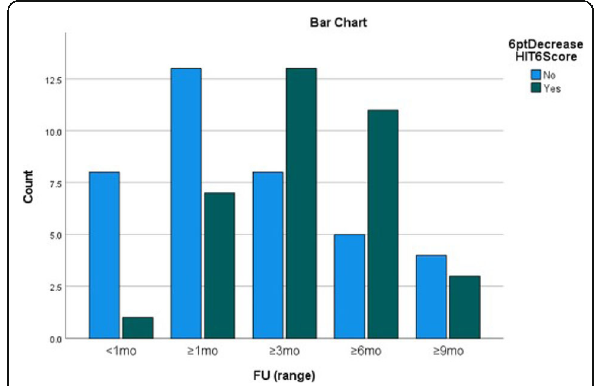
Fig. 2 (abstract P0117). See text for